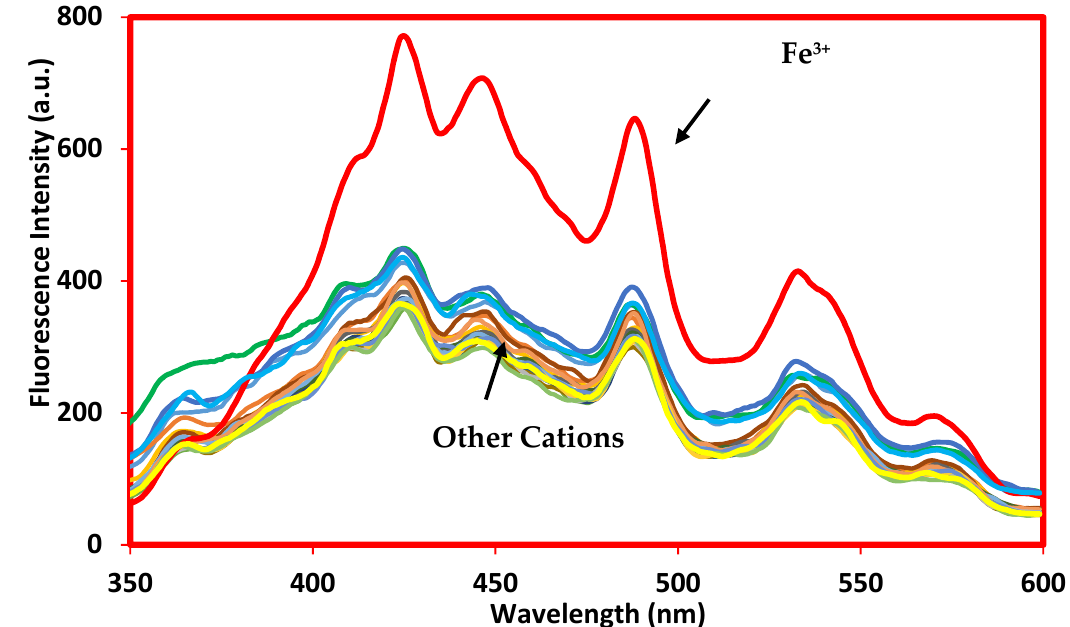
Figure 7. Fluorescence emission of SBA-Is-TAP (3 mL H 2 O suspension, 0.2 g L − 1 ) by different cations including Na + , Mg 2+ , Al 3+ , K + , Ca 2+ , Mn 2+ , Cd 2+ , Co 2+ , Cu 2+ , Li + , Zn 2+ , Ni 2+ , Ba 2+ , Hg 2+ , Sr 2+ , Cs + , Pb 2+ , Fe 2+ , Cr 3+ , Ag + , and Fe 3+ (100 µ L, 1 × 10 − 4 M, λ ex = 220 nm and λ em = 420 nm).